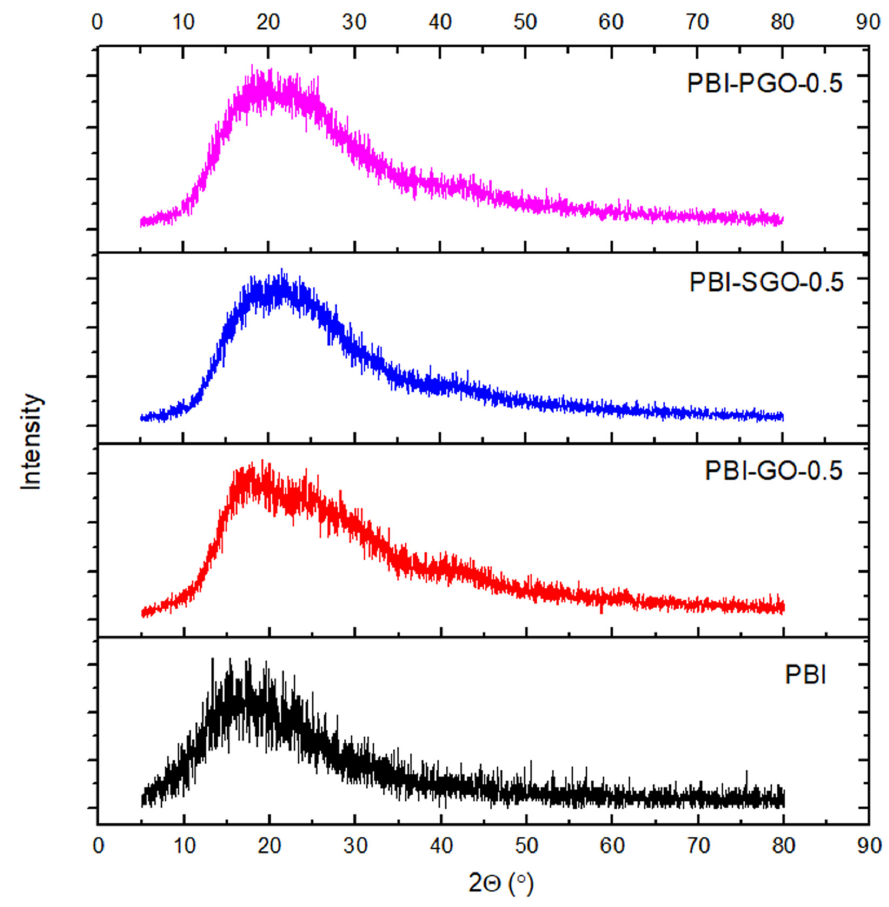
Figure 5. X-ray diffraction (XRD) spectrum of PBI composite membranes.